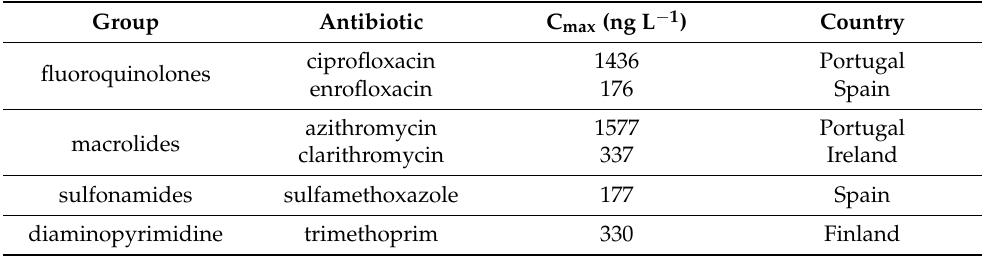
Table 4. Summary of the results in a recent study of 7 WWTPs in the European scenario [60].